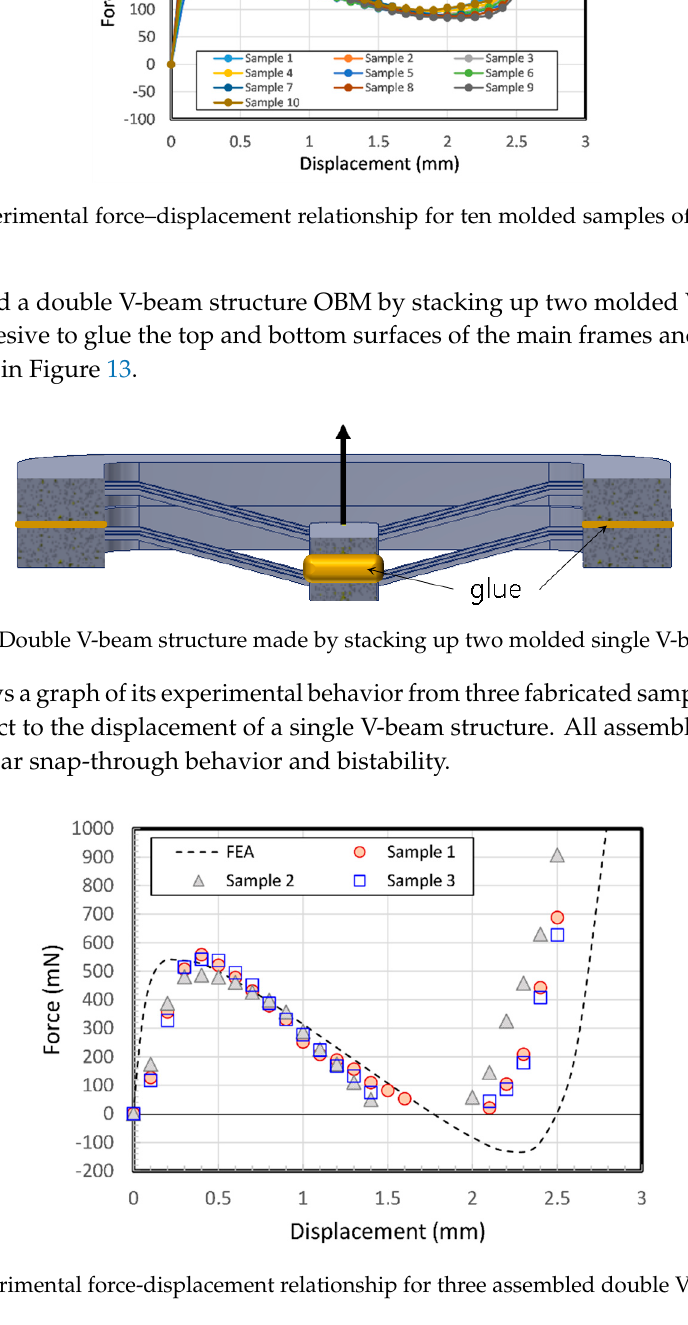
Figure 14. Experimental force-displacement relationship for three assembled double V-beam samples.